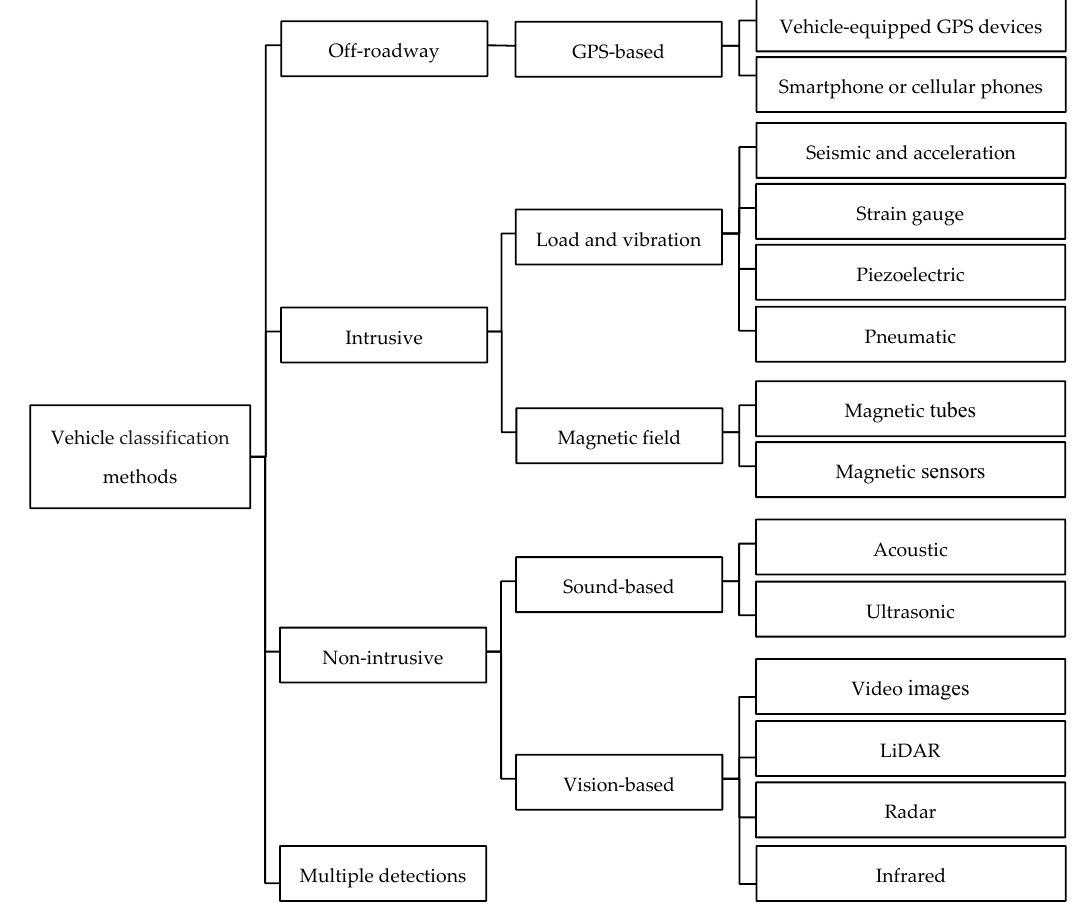
Figure 1. The methods used for VC.